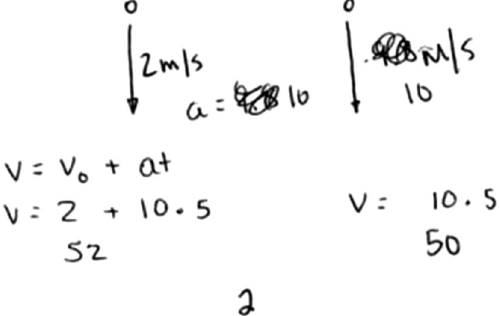
FIG. 5. Student work from Kuo et al. [21] exemplifying a “ plug and chug ” type of